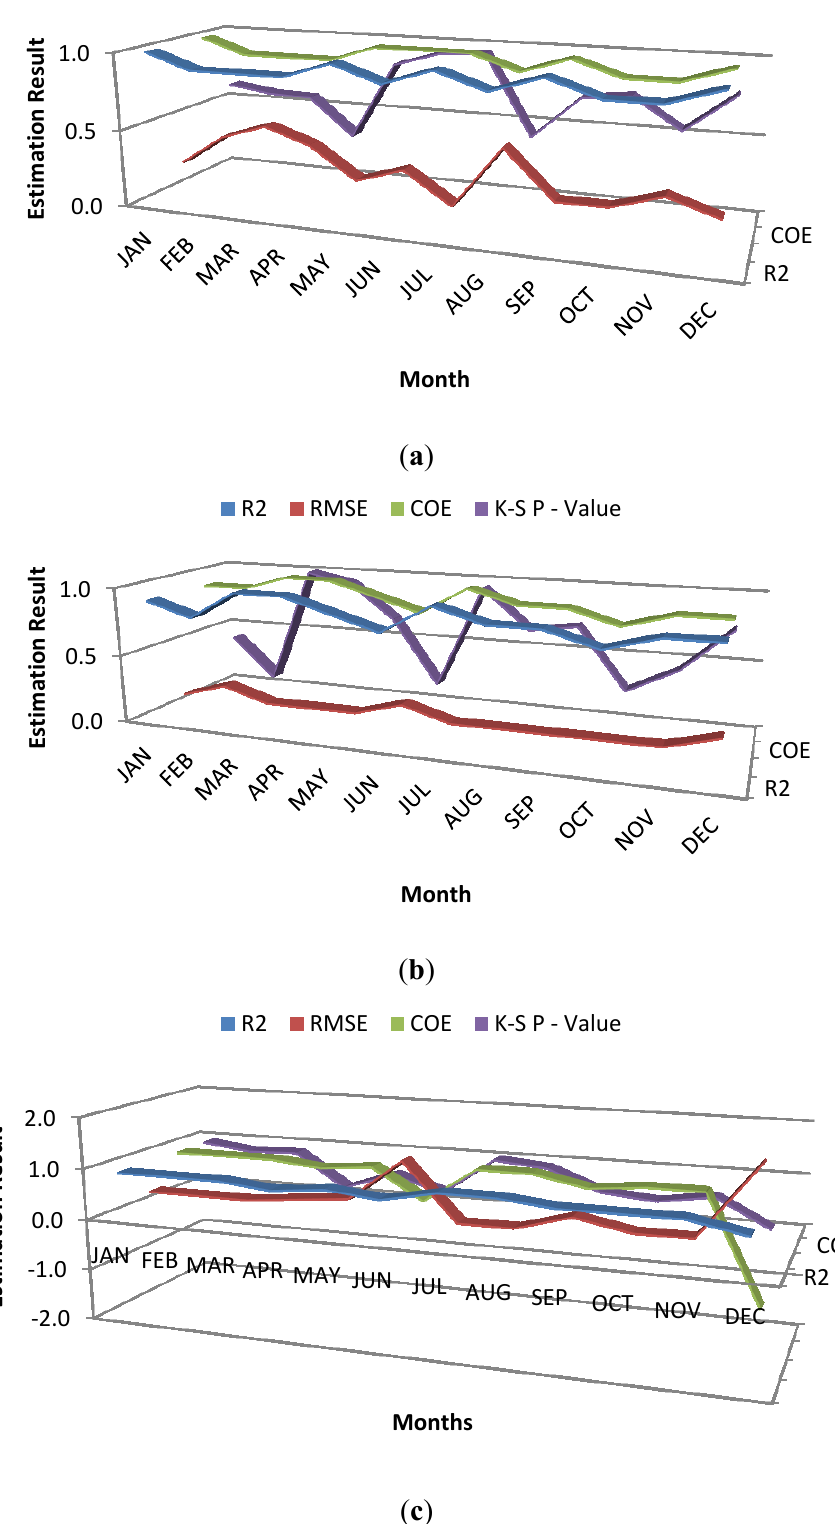
Figure 13. Estimation of the accuracy and goodness-of-fit of the Weibull distribution to the sites wind speed data: ( a ) Ado Ekiti; ( b ) Ikeja; ( c ) Lagos Island; ( d )